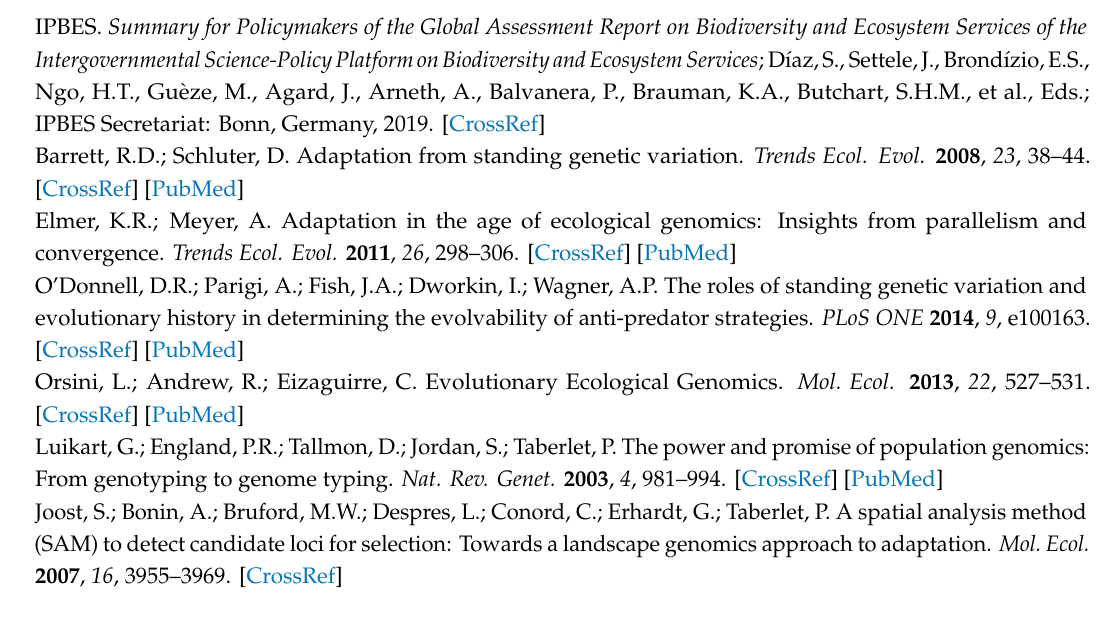
Figure S1: Workflow of the landscape genomic analysis with Samßada, Figure S2: Principal component analysis biplot of individuals and explanatory variables, Figure S3: Genes associated with environmental variables, Table S1: Sequence coverage for each individual at all 17518 SNPs, estimated using VCFtools 0.1.16, Table S2: Selected WorldClim environmental and bioclimatic variables and the values of the variables at the sample locations, Table S3: Nucleotide diversity and inbreeding coe ffi cients, Table S4: Definitions of seven WordClim bioclimatic variables used in the